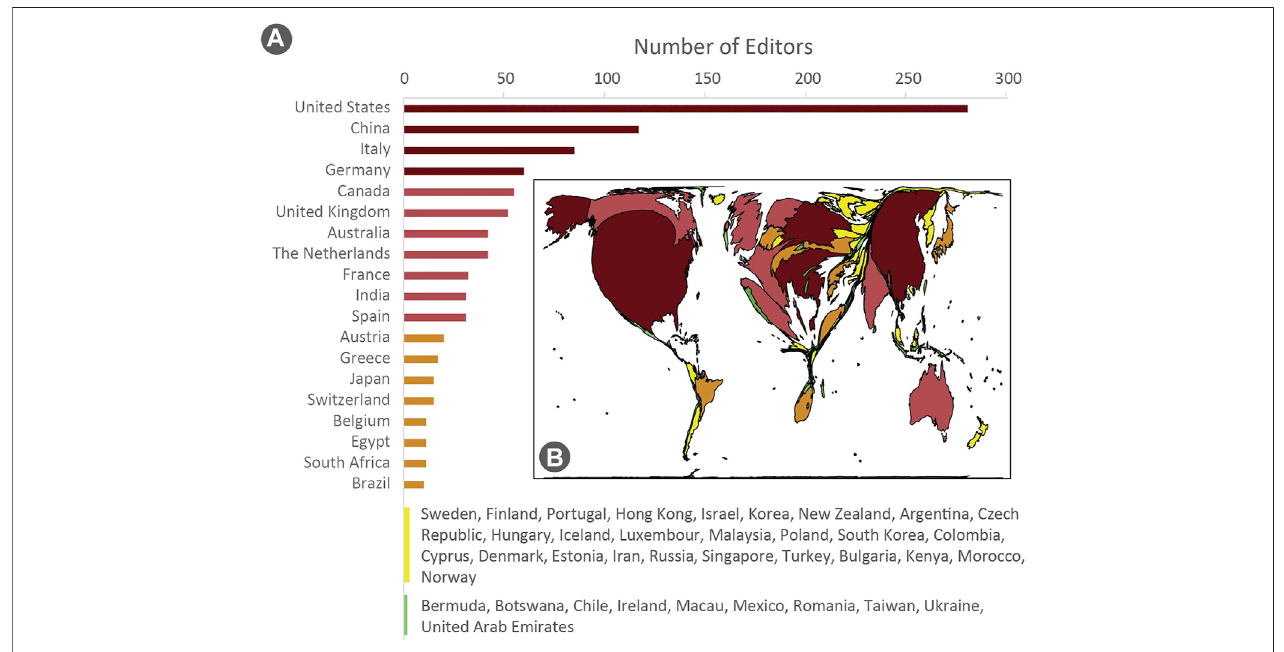
FIGURE 2 | Global distribution of editorial board members ( n = 1055) within 30 peer reviewed journals in the remote sensing discipline. (A) Count of editors per country (including Special Administrative Regions). (B) World cartogram (Gastner et al., 2018) weighted by number of editors demonstrating the skew towards the United States, China, Italy, and Germany with negligible contribution from South America and Africa. Note that regions identi fi ed in yellow each have between two and eight editors identi fi ed, while those in green have one editor.